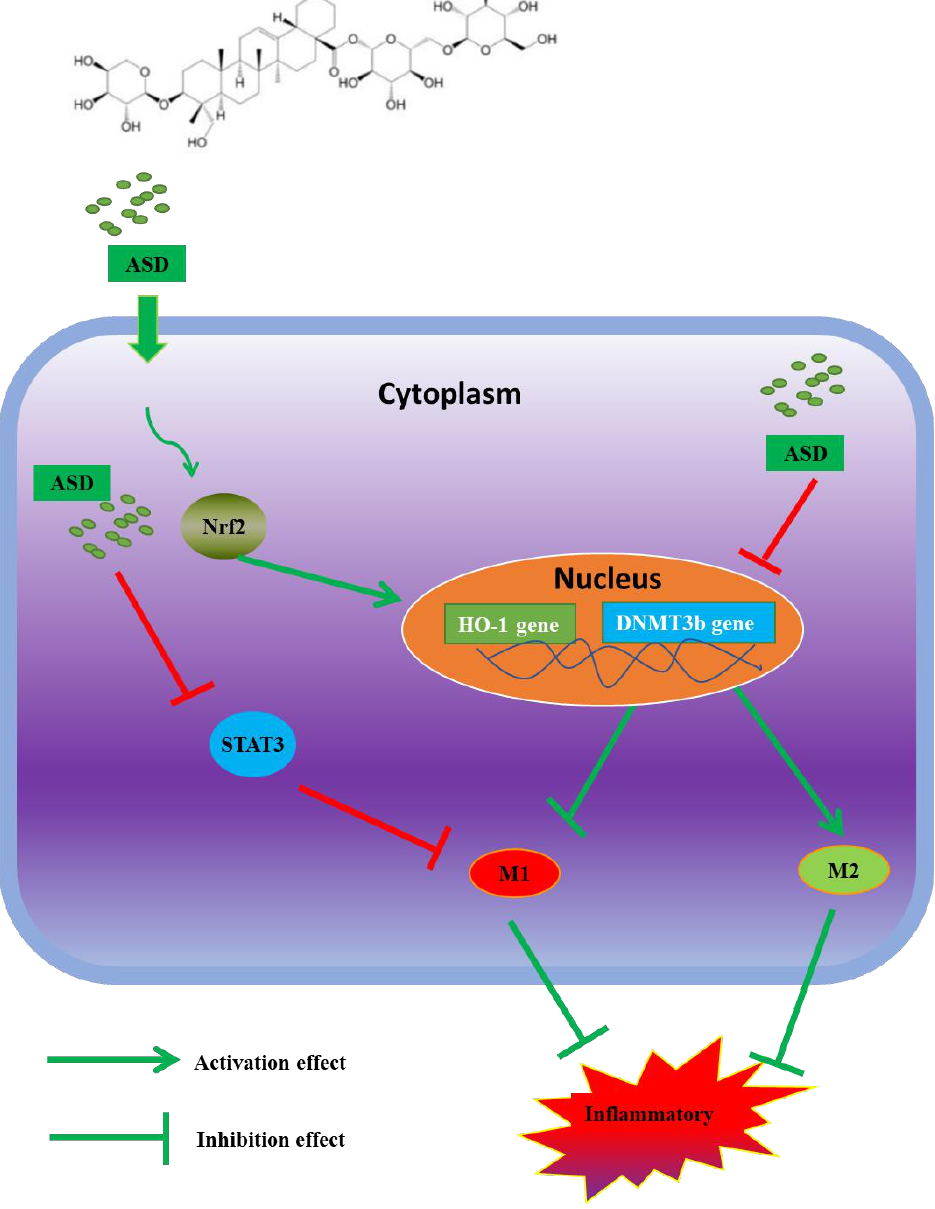
Figure 7. Diagram of the proposed molecular mechanism by which ASD activates RAW264.7 macrophages (under LPS stimulation). ASD inhibits the inflammatory reaction by inhibiting the IL-6-STAT3-DNMT3b axis and simultaneously activates the Nrf2/HO-1